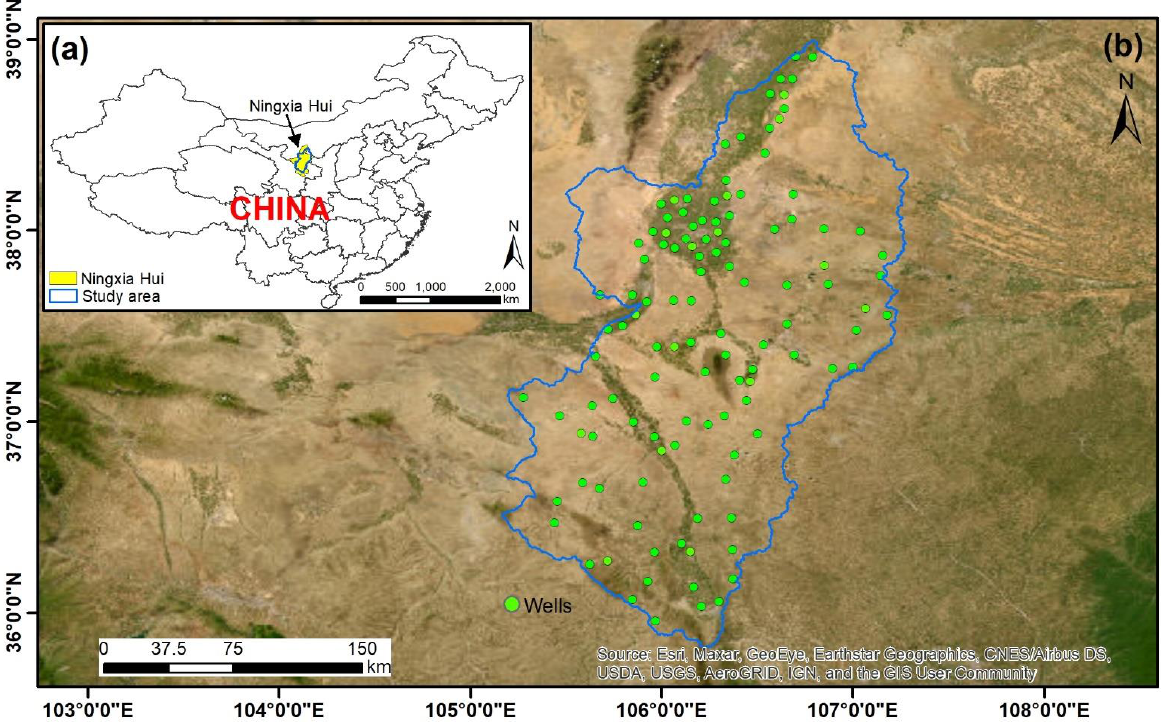
Figure 1. ( a ) Location map of the present study area is marked in the blue polygon that covers the majority of Niangxia Hui Region; ( b ) watershed of the study area overlain by well data.